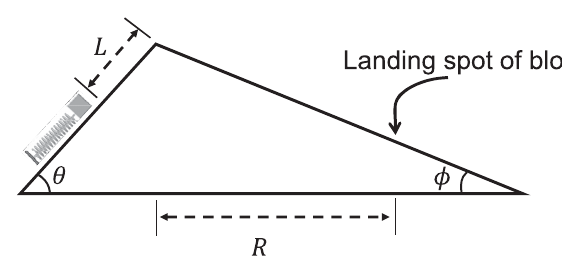
FIG. 1. Types of synthesis problems: (a) sequential and (b)